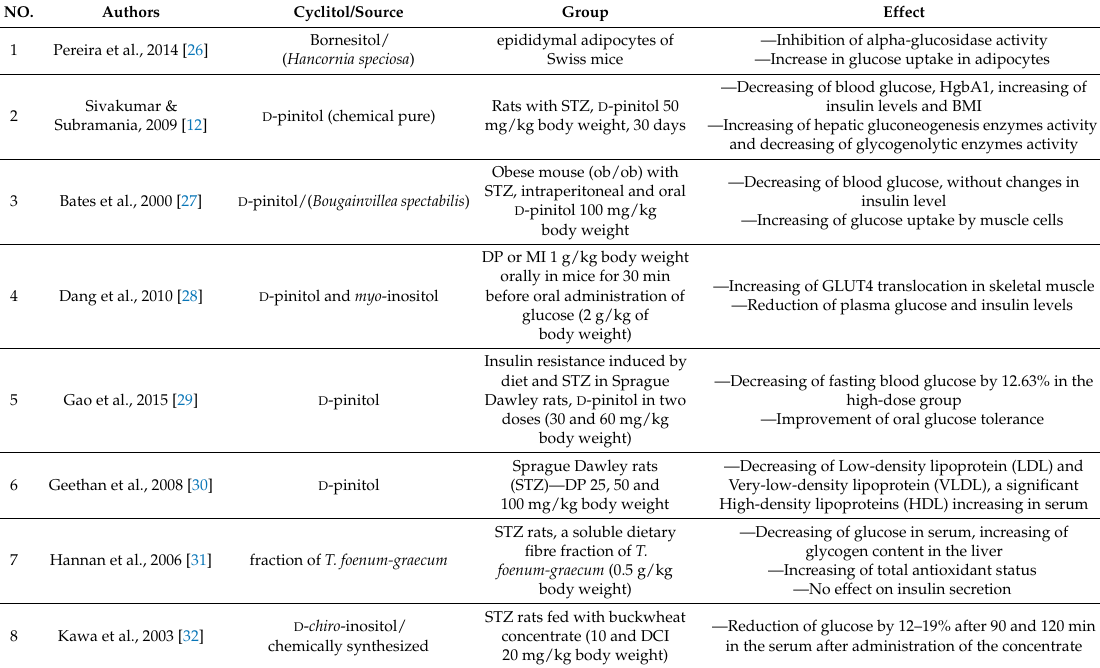
Table 1. The effect of cyclitols on animals’